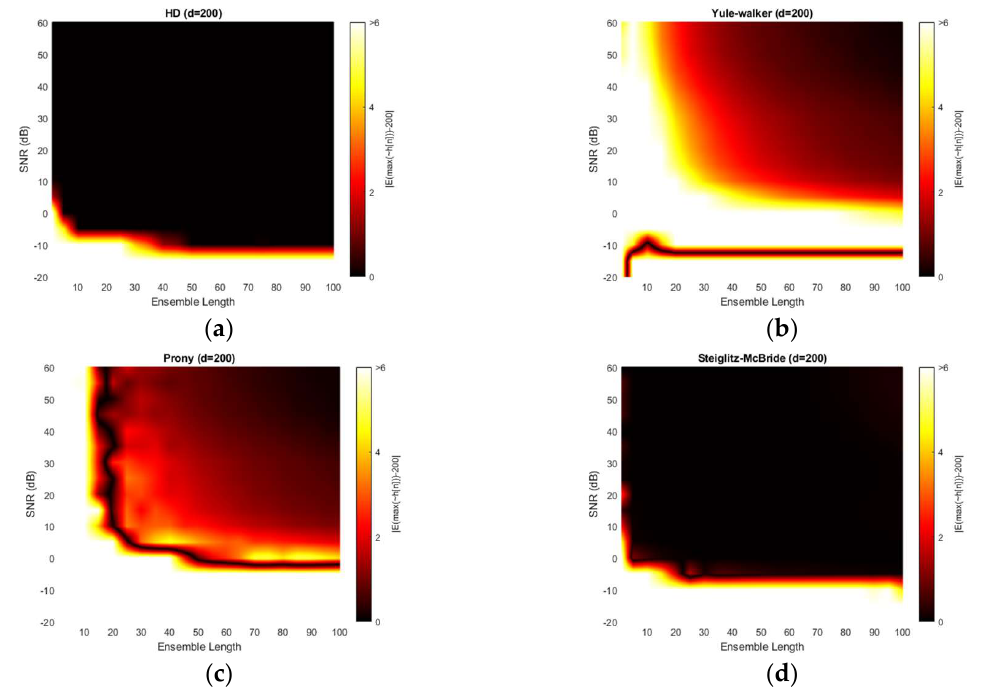
Figure 15. Average estimation error with given ensemble average length & SNR for 200-sample delay: ( a ) non-parametric HD; ( b ) Yule-walker HD; ( c ) Prony HD; ( d ) Steiglitz-McBride